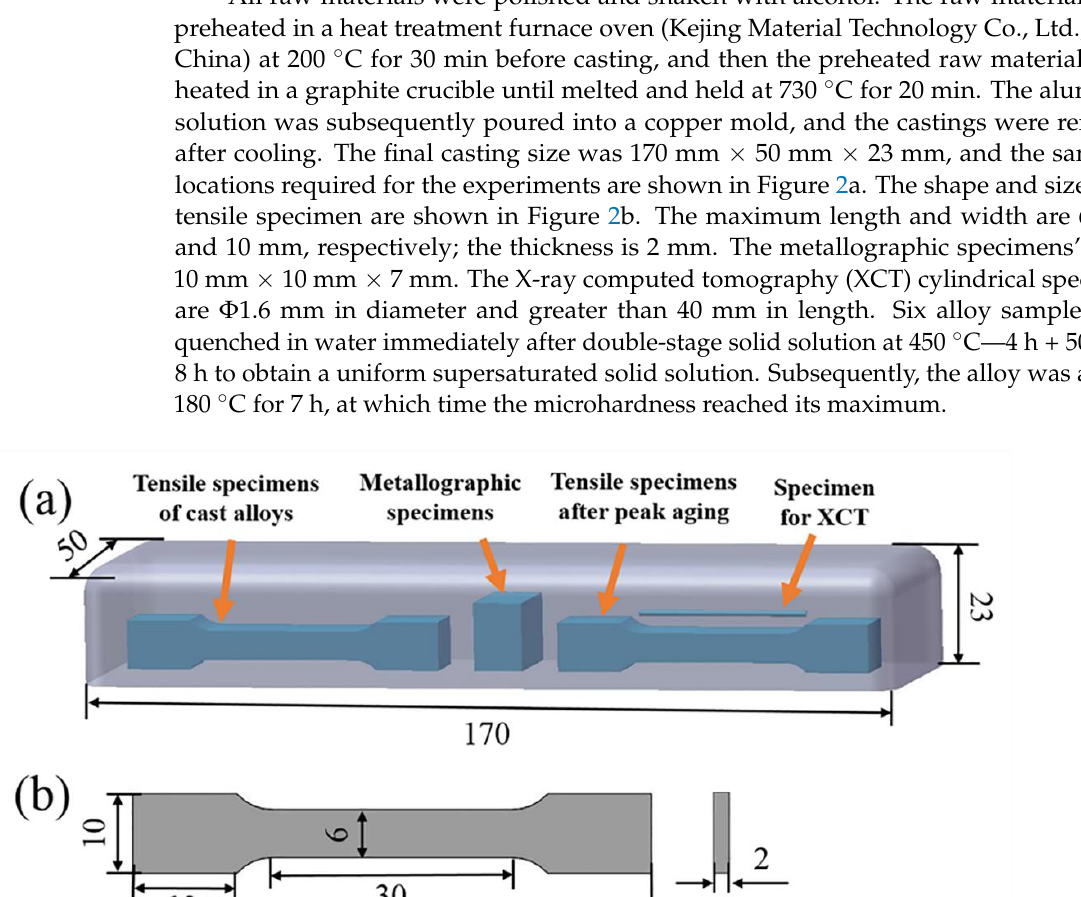
Table 1. Chemical compositions of the aluminum alloys (wt.%).